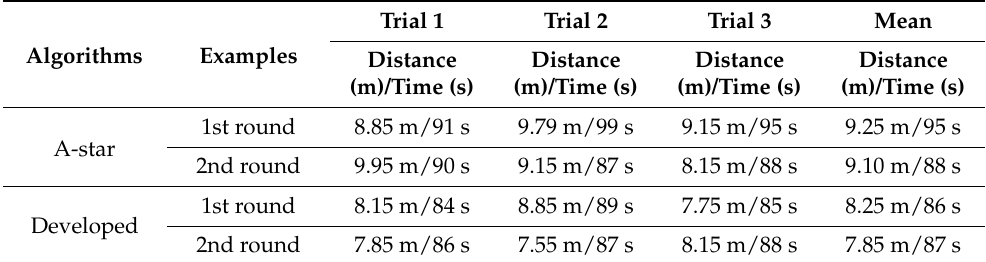
Table 2. Comparison of A-star with the proposed